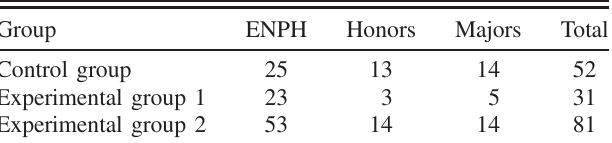
TABLE III. Populations of the control group (lecture-based course), experimental group 1 (transformed course taught by original professor, D. J.), and experimental group 2 (transformed course taught by second professor, K. M.) broken down by specific student programs. The physics student populations (both honors and majors) vary from year to year, while historically the ENPH are nearly constant in both number and quality; the reason for the population increase in EG2 was a change in frequency the course was offered (from twice a year to once a year) between EG1 and EG2.